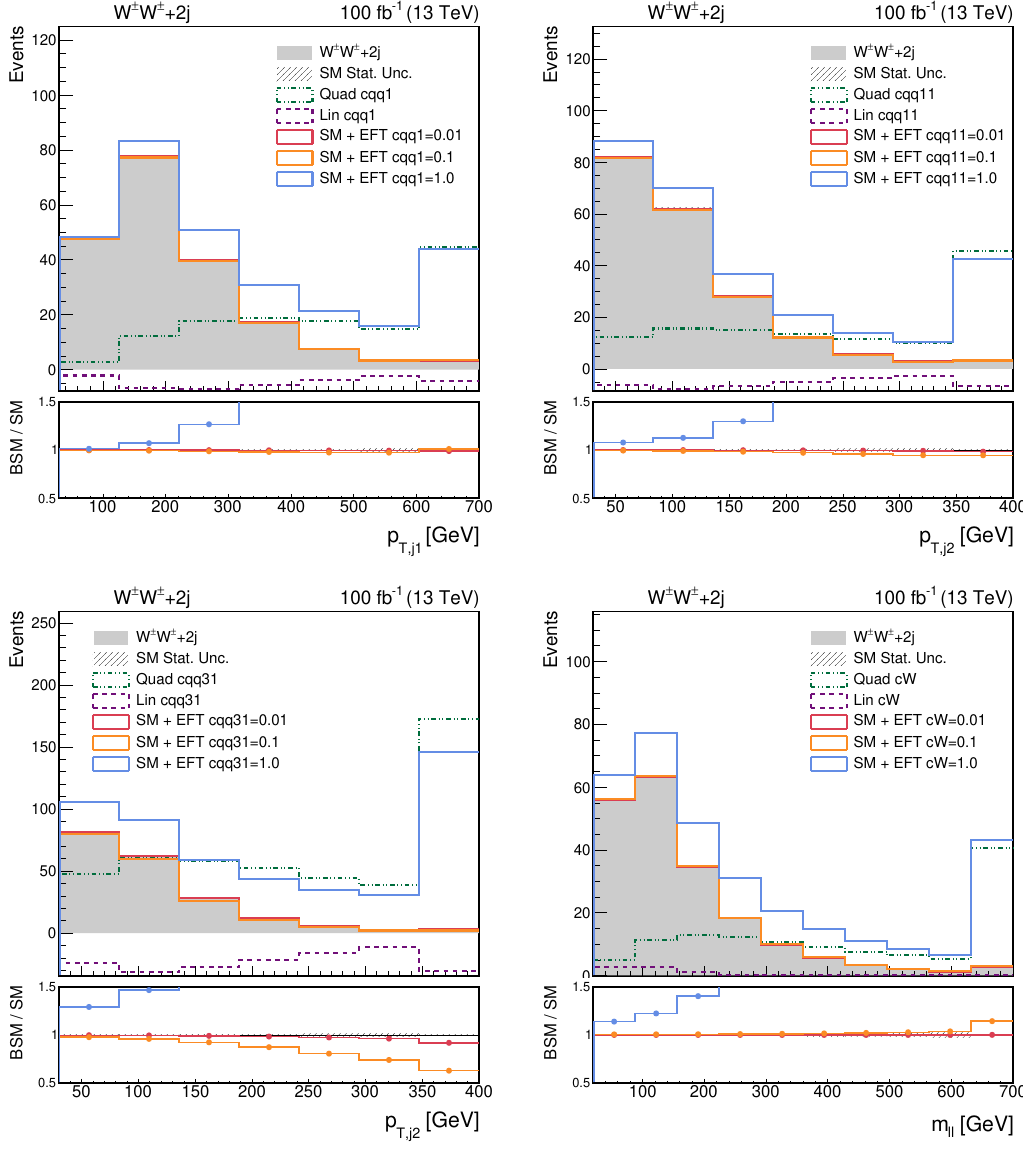
Figure 12 . Comparison of SM (filled histograms) and BSM (lines) expected number of events after the event selection in table 4, for various observables and Wilson coefficients in the SSWW+2j-EW process, at an integrated luminosity of 100 fb − 1 . Solid lines show the total prediction for one Wilson coefficient at a time, with c Λ 2 = 0 . 01 (red), 0 . 1 (orange) or 1 TeV − 2 (blue). The pure interference α / (quadratic) EFT component, normalized to c Λ 2 = 1 TeV − 2 , is indicated with a purple (green) α / dashed line. For all distributions, the last bin comprises all the overflow